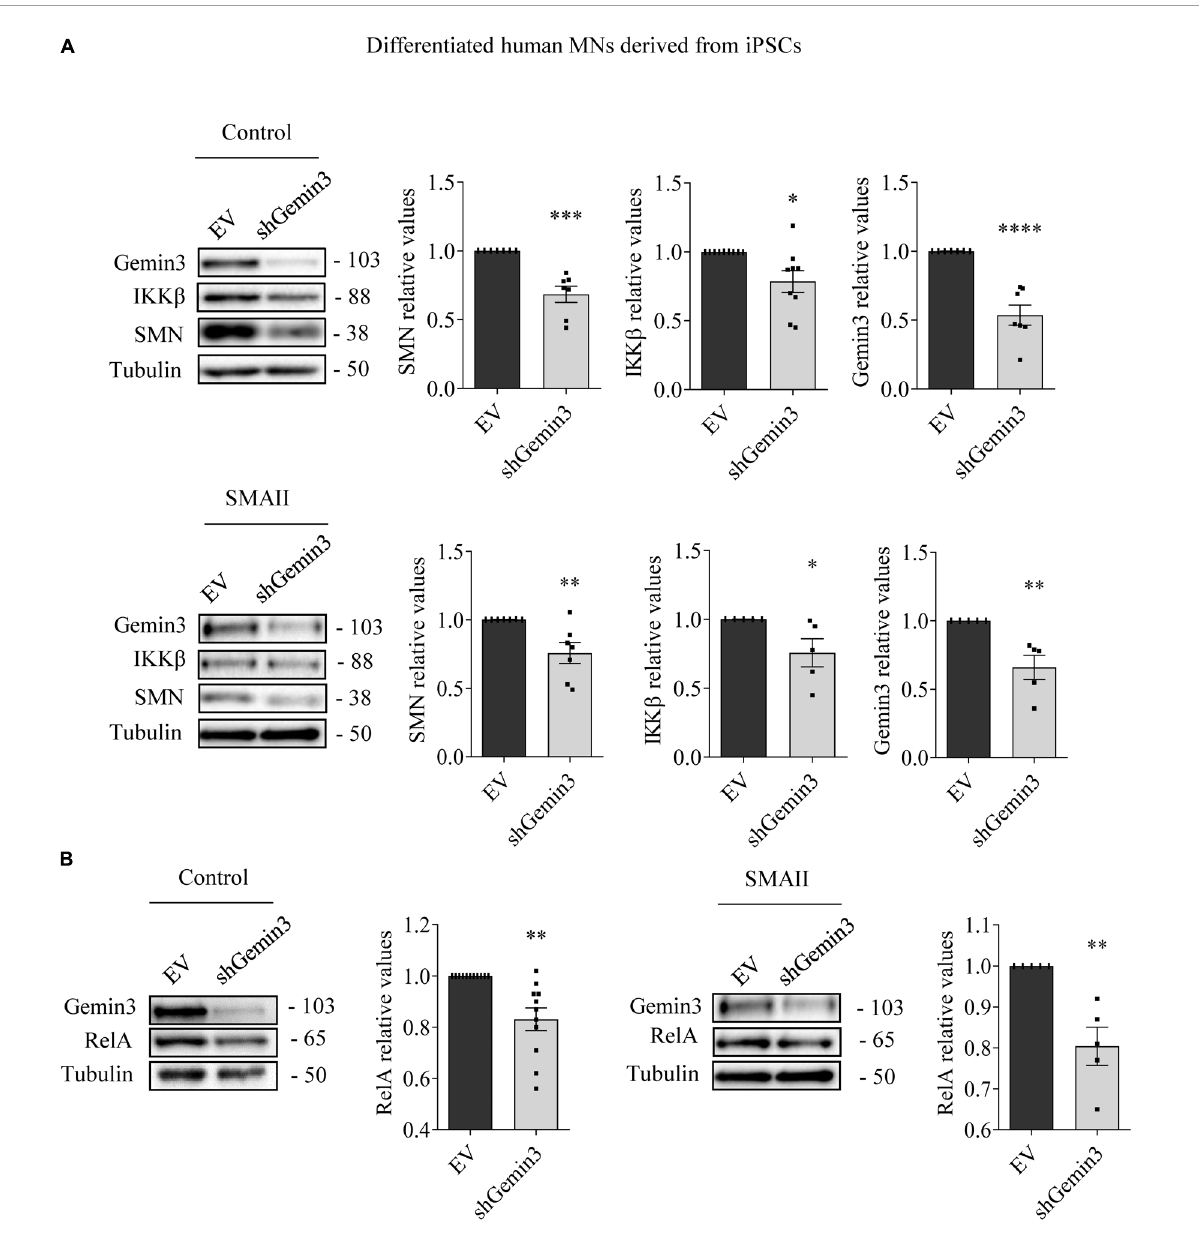
FIGURE5 Gemin3 knockdown reduced survival motor neuron (SMN), IKK β , and RelA protein level in differentiated human motoneurons (MNs). Control and SMAII human MNs were plated and transduced with lentivirus containing shGemin3 construct or the empty vector (EV). Protein extracts from 7 days transduced cells were submitted to western blot using anti-Gemin3, anti-IKK β , anti-RelA, and anti-SMN antibodies. Membranes were reprobed using anti- α -tubulin antibody. Graph values represent the expression of Gemin3 (A) , SMN (A) , IKK β (A) , or RelA (B) versus α -tubulin and correspond to the quantification of at least five independent experiments ± SEM. Asterisks indicate significant differences using Student t -test ( ∗ p < 0.05; ∗∗ p < 0.005; ∗∗∗ p < 0.0005; ∗∗∗∗ p <